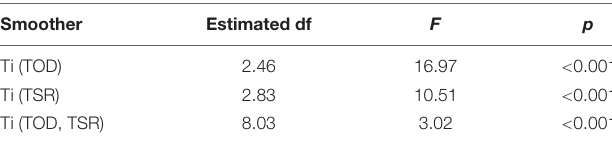
TABLE 3 | Coefficients and significance of smooth terms for time of day (TOD), time since release (TSR), and their tensor interaction from a beta generalized additive mixed model predicting mean resultant